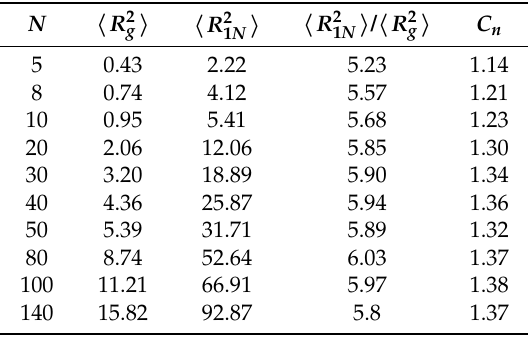
(cid:10) (cid:11) R 2 were obtained by averaging over 1 N